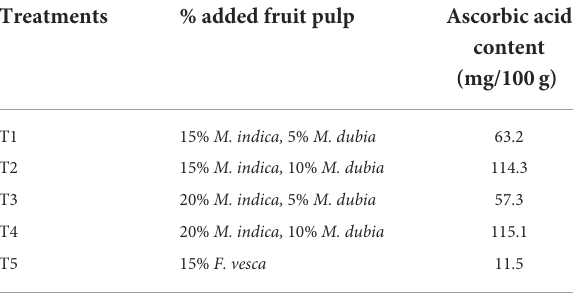
TABLE 5 Ascorbic acid analysis of the yogurts.